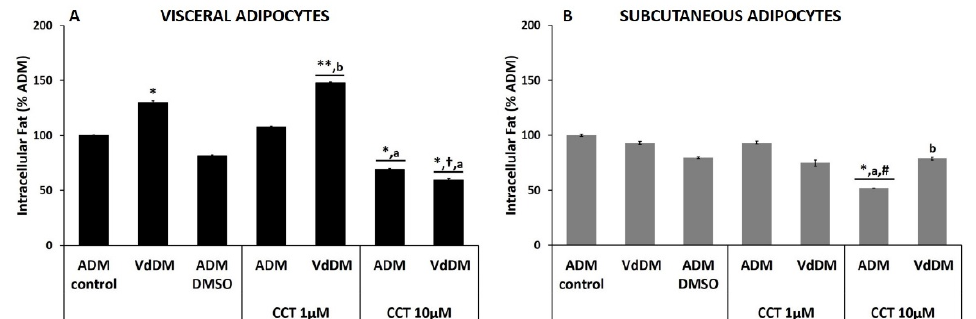
Figure 5. Effect of VdDM secretome and the CCT on the differentiation of healthy PA. The maximum intracellular fat detected for control differentiation (ADM-control) was set at 100%. Relative values of intracellular fat in different conditions are shown: VdDM-differentiated cells, ADM–DMSO, and CCT applied to ADM- and VdDM-differentiated cells. Values were obtained at 17 days post-induction. Panel ( A ): percentage of intracellular fat of visceral adipocytes. Panel ( B ): percentage of intracellular fat of subcutaneous adipocytes. Bars indicate mean ± SEM of absorbance ( λ 517 nm) from at least three replicates of each condition. Significant differences are represented as: *, ** compared to ADM-control p < 0.05 and p < 0.01, respectively. † compared to VdDM p < 0.05. # compared to ADM–DMSO, p < 0.05. “a” comparisons between CCT dose, p < 0.05. “b” comparison between VdDM–CCT and ADM–CCT (same dose), p < 0.05.